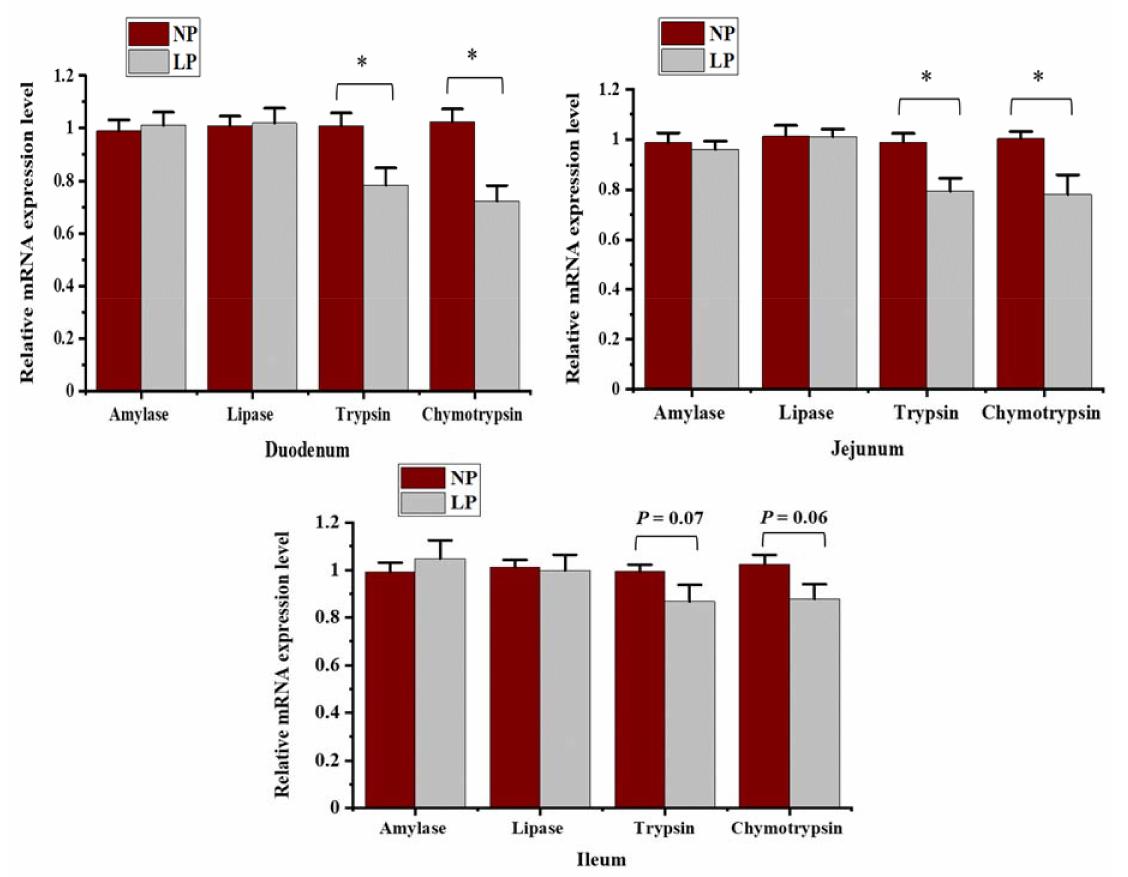
Figure 2. The relative mRNA expressions of α -amylase, lipase, trypsin and chymotrypsin in duodenum, jejunum and ileum in goats fed a low-protein diet. The results are presented as the mean ± SE; * = p < 0.05.